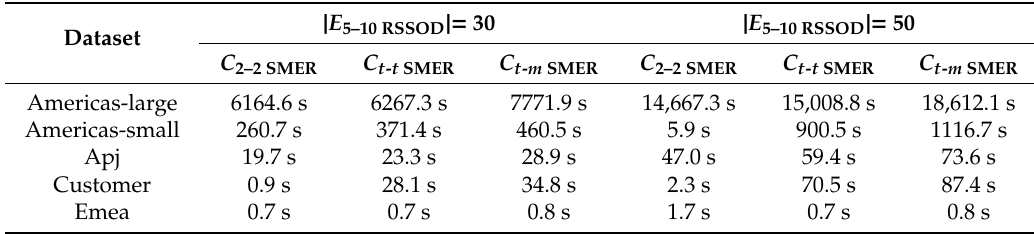
Table 14. Execution time with 5–10